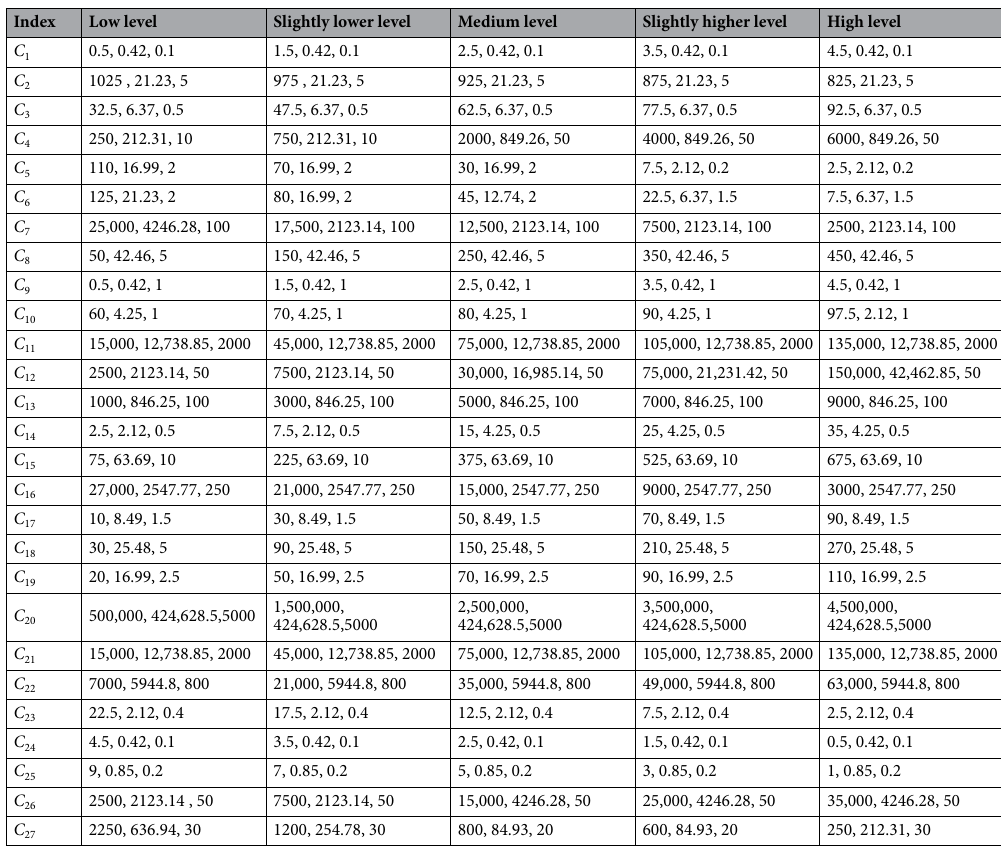
Table 9. Toughness evaluation index normal cloud